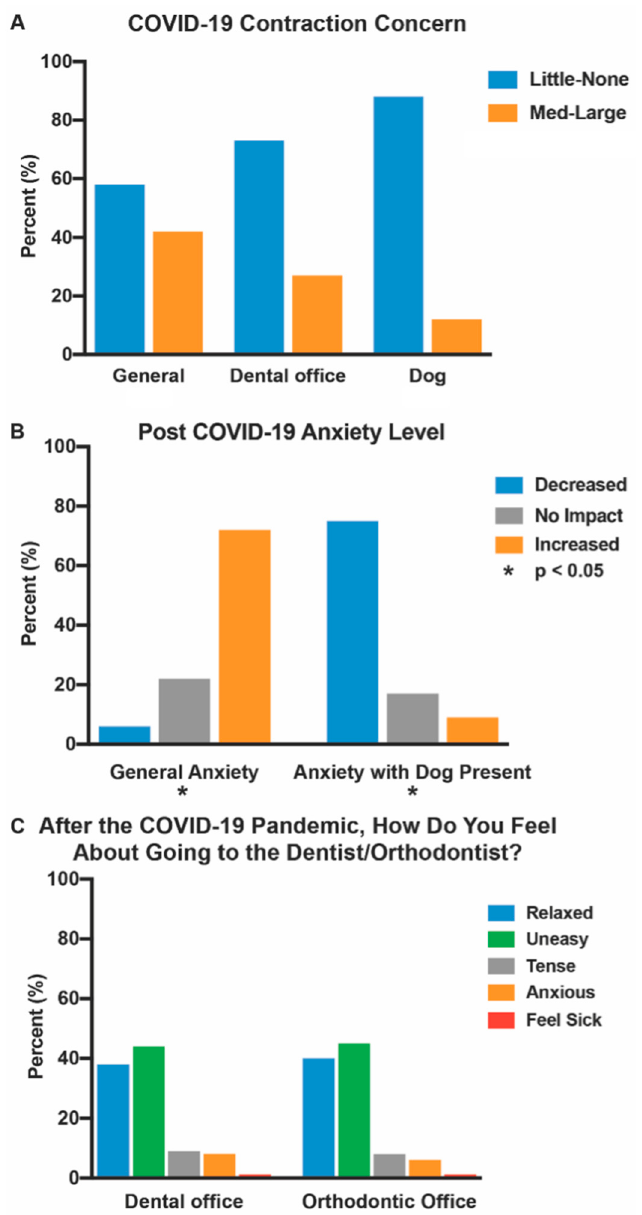
Figure 4. Concerns regarding COVID-19. ( A ) Percentage of participants responding “little concern” or “no concern” (pooled data, blue) versus “medium concern” and “large concern” (orange) with regard to contracting COVID-19 in general, at the dentist’s office, or from a dog (Table S4); ( B ) Perceived impact of COVID-19 on general anxiety and anxiety with a dog present (decreased- blue; no impact—grey; increase—orange) (Table S5); ( C ) Concern regarding dental professionals after COVID-19 in a dental office or orthodontic office (relaxed—blue; uneasy—green; tense—grey; anxious—orange; feel sick—red) (Table S6).